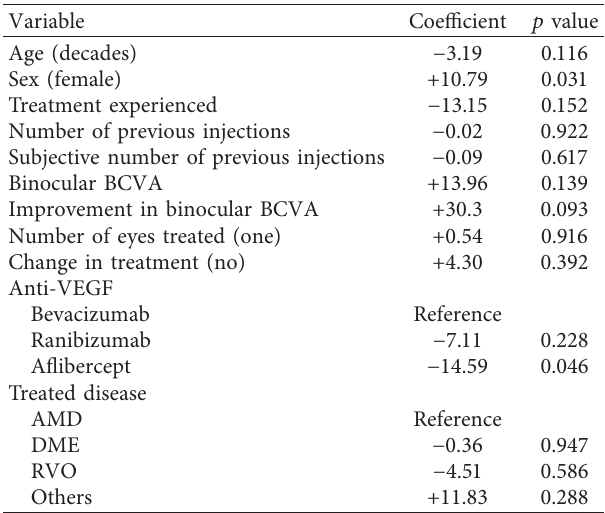
Table 2: Univariate linear regression analysis relating the levels of anxiety with the continuous and categorical